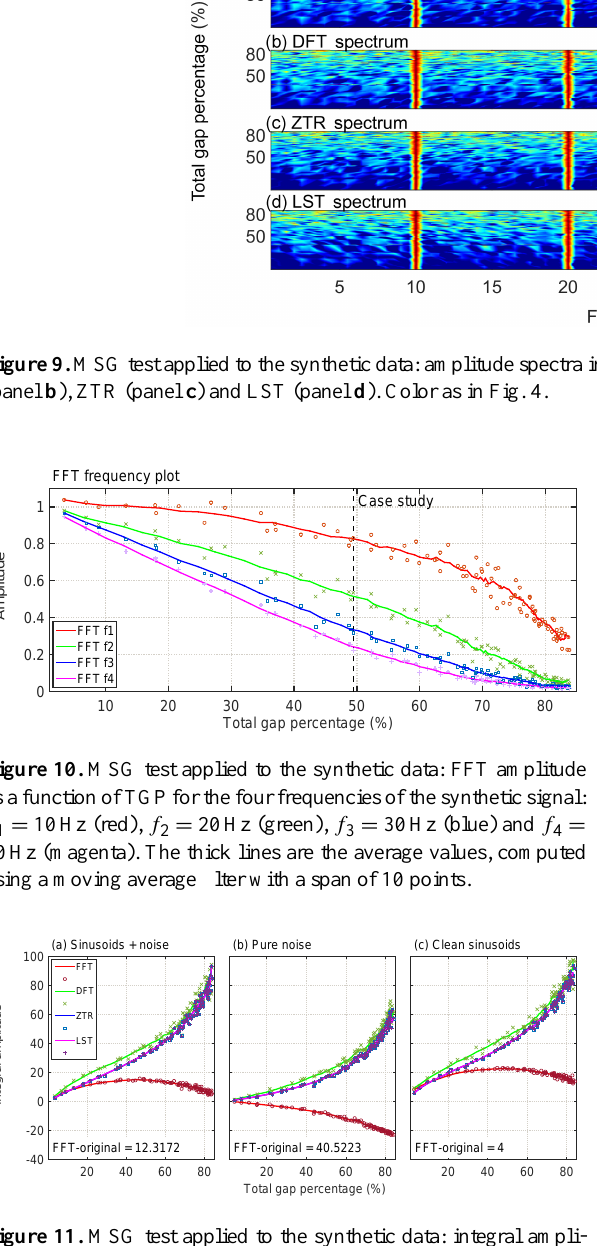
Figure 11. MSG test applied to the synthetic data: integral ampli- tudes as a function of TGP. The thick lines are the average values of the individual integral amplitudes. The format is identical to Fig. 6.